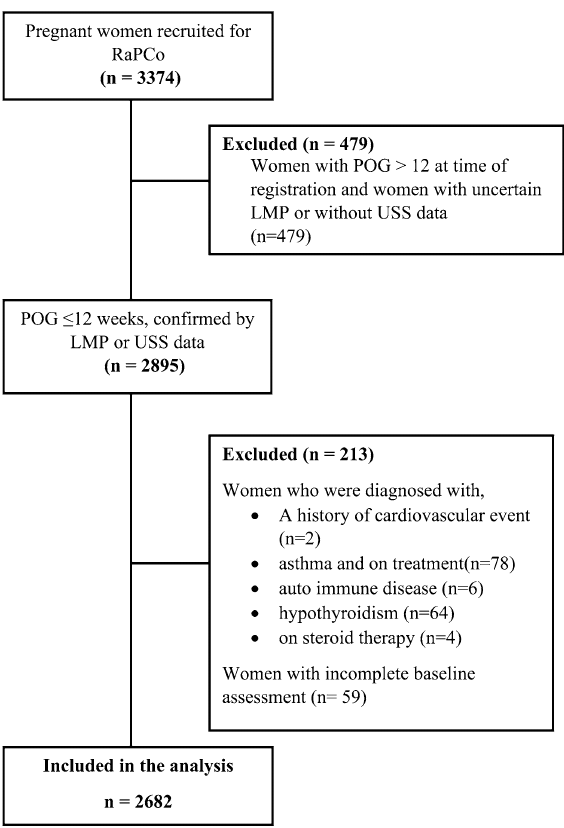
Figure 1. Flow chart of inclusion and exclusion criteria of participants for the